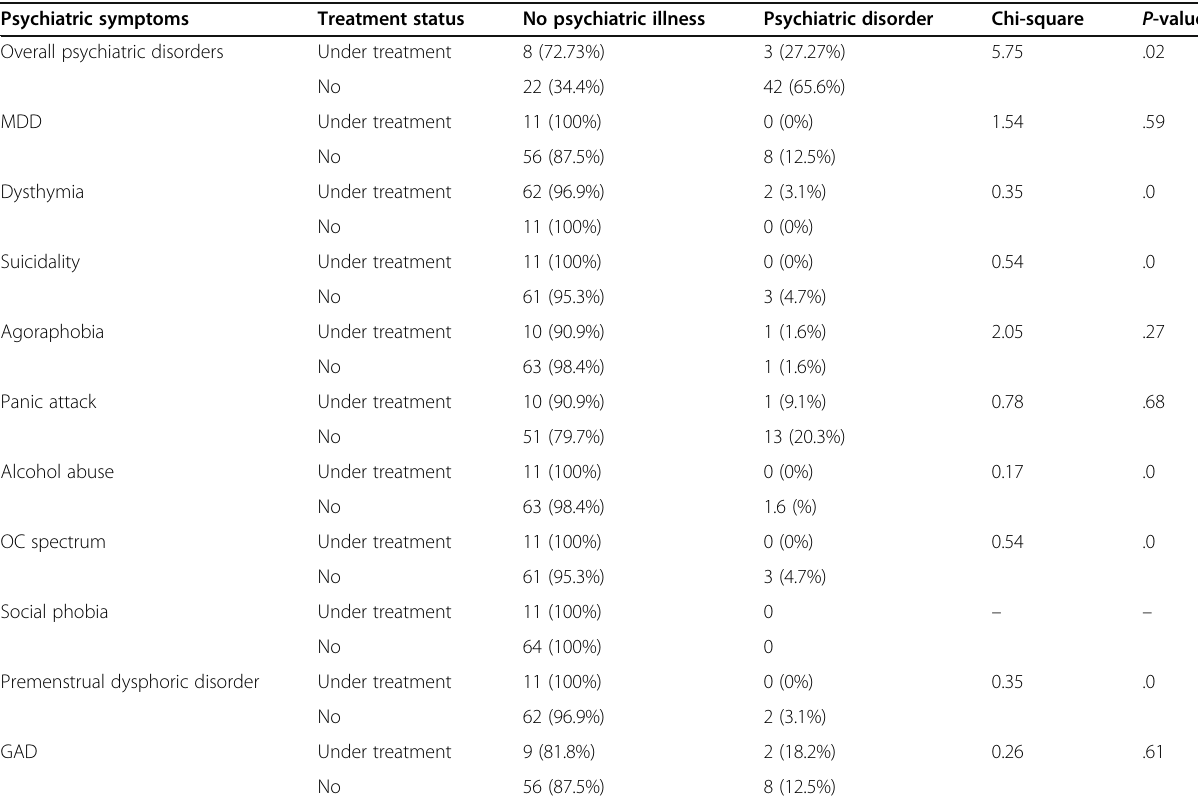
Table 4 Status of treatment and its association with psychiatric symptoms among cases ( n =75) Psychiatric